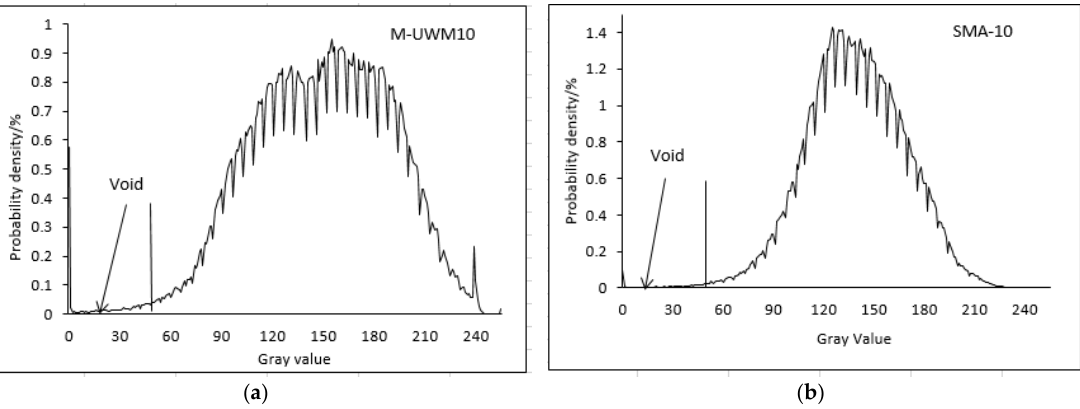
Figure 11. Grey level ‐ probability density distribution curves: ( a ) M ‐ UWM10; ( b ) SMA10.